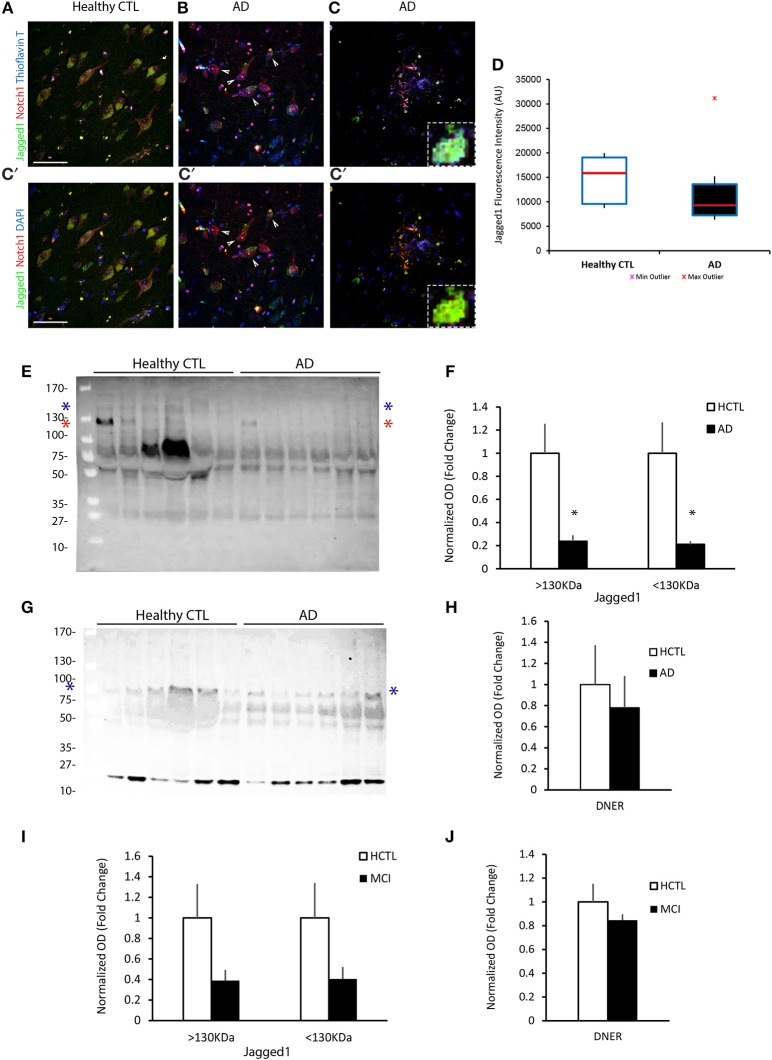
Jagged1 expression in brains and CSF of AD patients. Representative double fluorescent immunolabelings for Jagged1 (green) and Notch1 (red) counterstained with Thioflavin-T or DAPI (blue) on postmortem brain sections comprising the hippocampal CA fields from healthy age-matched controls and AD patients (A–C). In the healthy controls, Jagged1 is localized to the somata of neurons where also Notch1 is expressed. As expected, Thioflavin-T labeling is negligible (A,A′). AD sections show fibrillary aggregates (B,B′) and (C,C′) core plaques double positive for Notch1 and Thioflavin-T. Jag1 expression is scattered in the parenchyma and low in, degenerated neurons (white arrows) (B,B′). Jag1 overlays in small double positive aggregates for Notch1 and Thioflavin-T (100x magnification) in radiating plaques with a visible reduction in Jagged1 cellular expression (B–C′). Box plots summarizing the quantification of the fluorescence intensities of Jagged1 immunolabeled neurons shows a significant reduction in Jagged1 expression in AD patients (p < 0.001) (D). Immunoblotting on CSF from 6 patients per condition reveals that Jagged1 bands over 130 KDa corresponding to the full length (blue star) and the one below 130 KDa (red star) indicating the soluble Jagged1 appear less represented in the CSF from AD patients (E). Bar graph showing the pattern of expression of Jagged1 bands >130 KDa (blue stars) and <130 KDa (red stars) (F). Representative immunoblotting of the CSF from the same patients with DNER shows the expected band <100 KDa (blue stars) and a stronger undefinded band <27 KDa. Intenstity of the bands at both molecular weights show a high variability independently of the condition (G). Bar graph summarizes the expression of the expected DNER band <100 KDa in CTLs and ADs (H). Bar graphs representing the quantification of the Jag1 bands >130 and <130 KDa and the DNER band <100 KDa in MCI patients and age-matched CTLs (I,J). Scale bars are 25 μm in (A,A′). All graphs represent mean ± SEM, *p < 0.05. AU, arbitrary units.